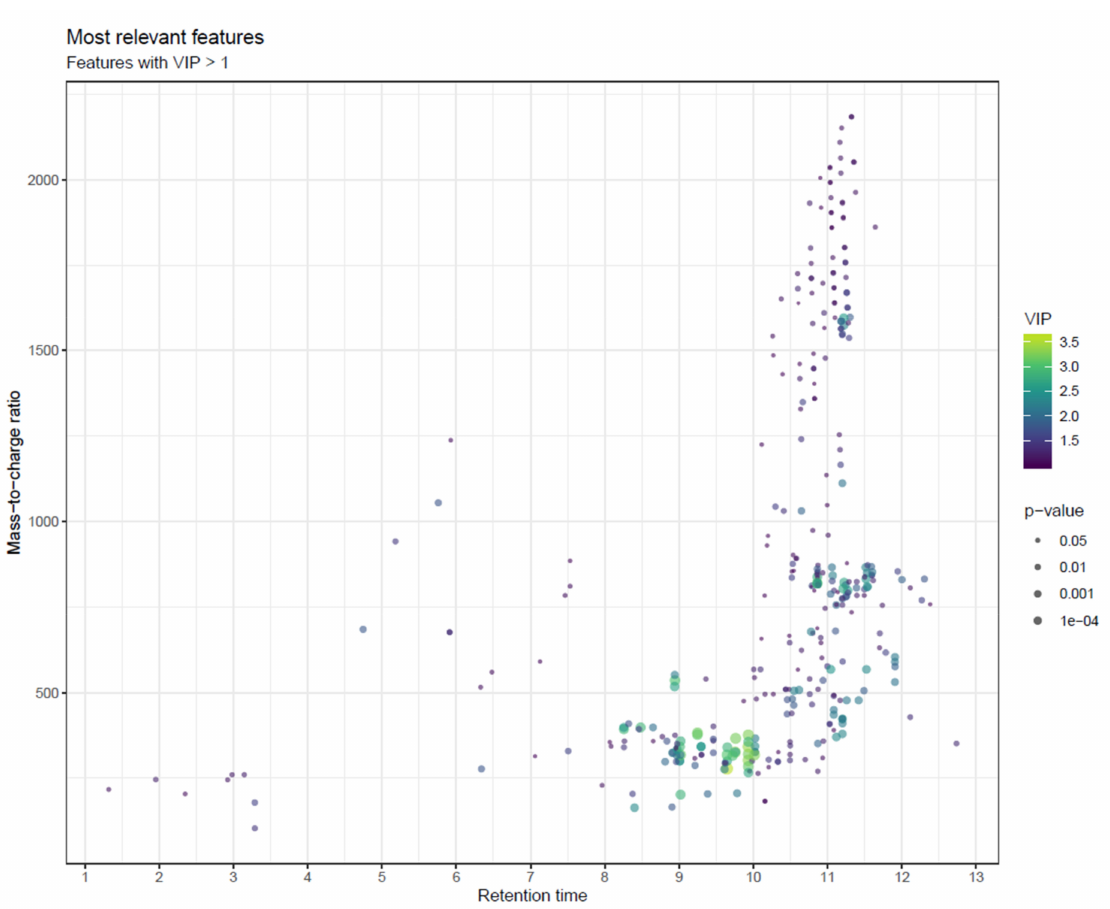
Figure 24. Scatter plot of molecular features in m / z vs retention time space, with the size of the points reflecting p -values from linear models testing the di ff erence in feature abundances between two time points. The points are colored by variable importance in projection (VIP)-value from a partial least squares-discriminant analysis (PLS-DA) model trained to separate the two time points. To avoid too many overlapping points, only points with VIP value > 1 are drawn. We can observe that the most interesting group of features has retention times around 9–10 min and m / z ratios around